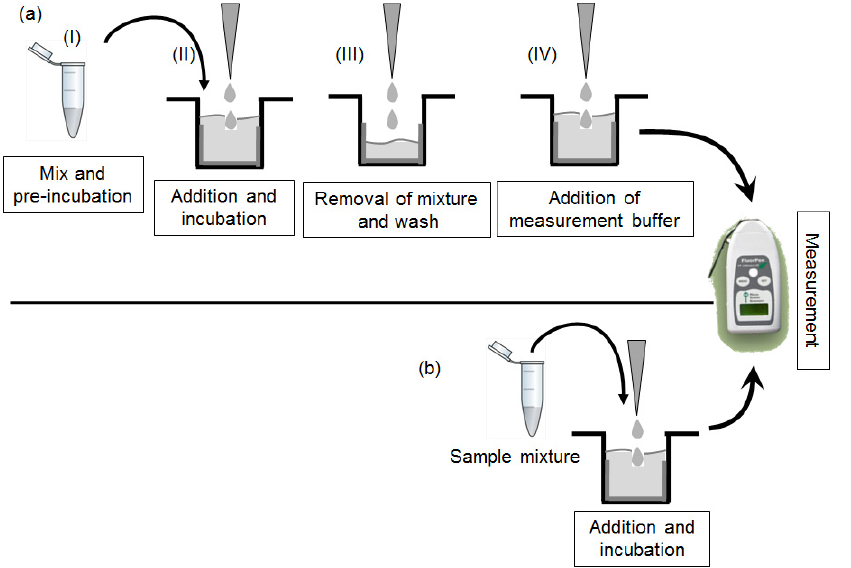
Figure 1. Comparison of the assay procedures of toxic metals using GFP-tagged trans factor and cis element in microplate wells. The previously developed procedure is composed of (I) mixing and 15-min pre-incubation of GFP-tagged trans factor with sample; (II) addition of the mixture to the well and 15-min incubation with immobilized cis element; (III) removal of the mixture and washing the well surface; and (IV) addition of